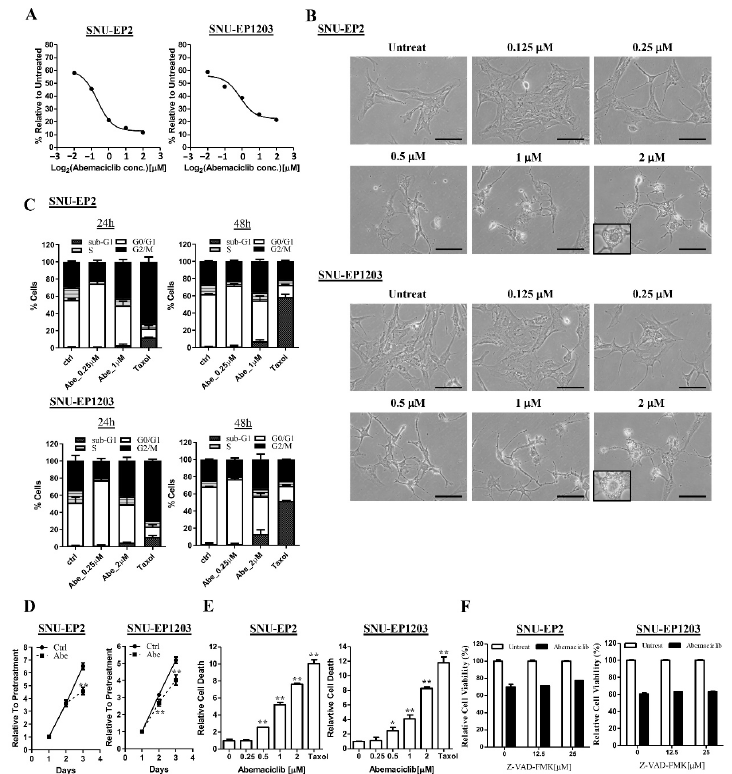
Figure 3. Abemaciclib treatment regulates cell proliferation and cell death in ependymoma cells. ( A ) SNU-EP2 and SNU-EP1203 cells were treated with abemaciclib for 72 h and the IC 50 value was